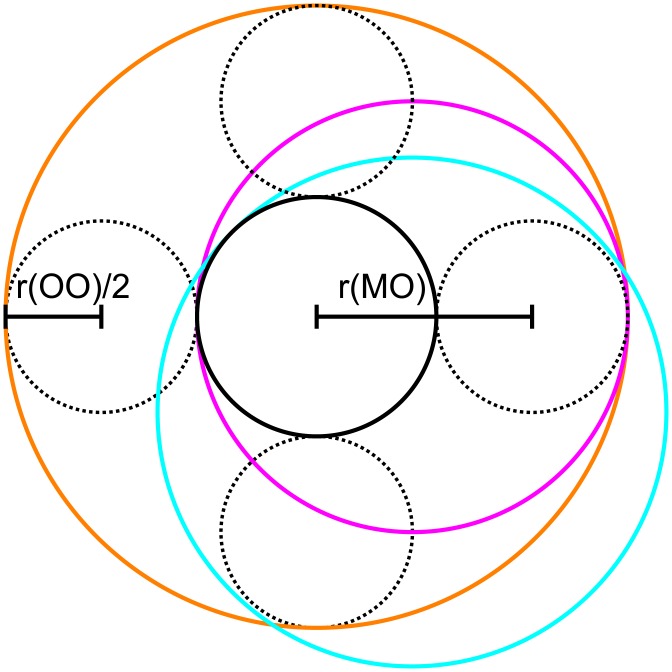
Schematic for the circumcircles that give the partially hydrated cation diameters, d
M+, used in the CSC simulations (not drawn to scale).They follow the replacement of four waters of hydration (dashed circles) in a plane perpendicular to the channel axis. Removal of one water does not change the diameter (0, 1 = orange). Loss of more waters reduces the diameter (2 = blue, 3 = pink) to a minimum when four (or more) waters are lost (4 = black). The actual dimensions are calculated from the experimental cation–water oxygen distance (r(MO)) and water oxygen–water oxygen distance (r(OO)).